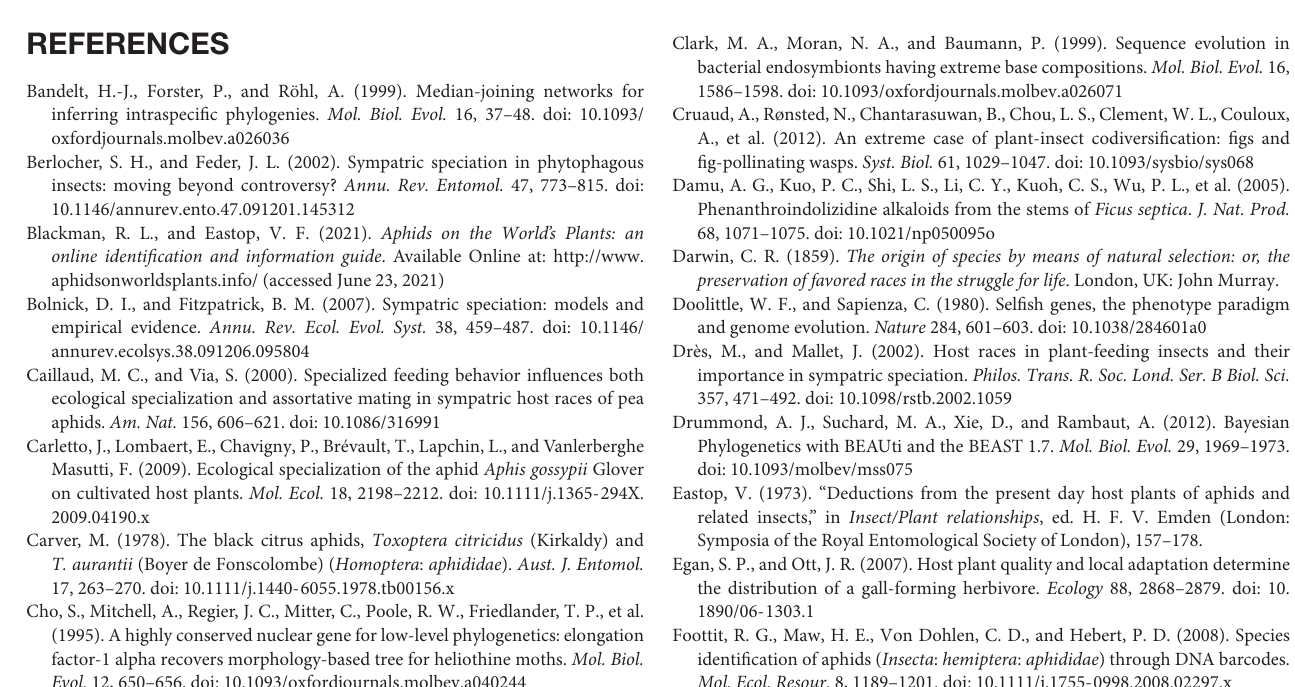
Supplementary Table 3 | The nucleotide composition and genetic distances of A. aurantii feeding on different host plants. Supplementary Table 4 | The distribution of intraspecific and interspecific distances among Aphis COI sequences. Supplementary Table 5 | Result of one-way ANOVA and post hoc LSD for morphological characters of A. aurantii samples collected on different host